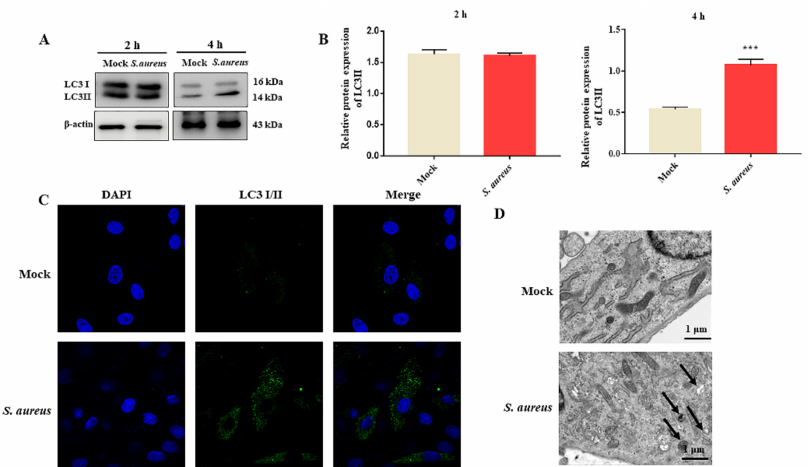
Figure 2. S. aureus induces gEECs autophagy. ( A , B ) Measurement of LC3II expression following S. aureus (10 MOI) infection for 2 h and 4 h using Western blot analysis. The results of the quan- tification are shown to the right. ( C ) gEECs were infected with S. aureus (10 MOI) for 4 h, and the LC3II-positive puncta were observed under the confocal microscope. Scale bars: 20 µ m. ( D ) After being infected with S. aureus (10 MOI) for 4 h, the gEECs were analyzed by transmission electron microscopy (TEM). The typical autophagic structures are clearly visualized: black arrowheads depict the autophagosome. Scale bars: 1 µ m. Each experiment was repeated three times. *** p < 0.001 vs. the mock group.